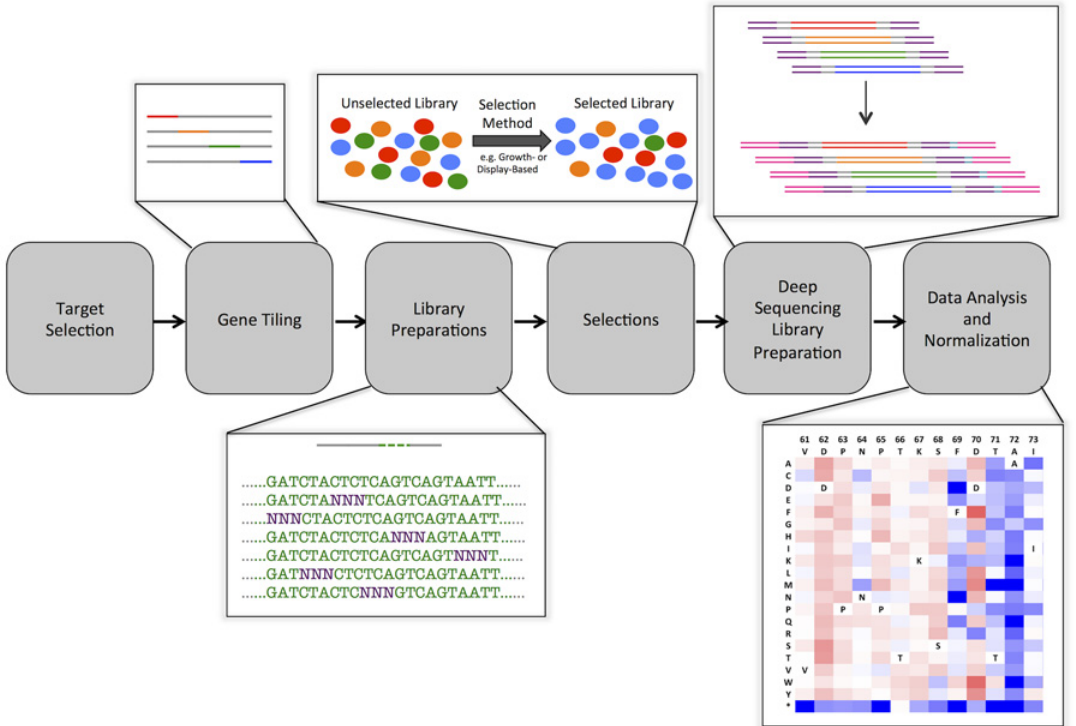
Fig 1. Overview of high-resolution sequence-function mapping process. Target Selection . Proteins of interest are selected for interrogation of sequence function relationships. A plasmid containing the gene-encoding sequence is generated. Gene tiling . Starting from this gene sequence, semi-overlapping tiles are generated to cover the entire gene. These tiles are either 150, 250 or 300 bp in length in order to be sequenced in paired-end mode on Illumina deep sequencing platforms. Library Preparation . The single-pot PFunkel method is used to generate a comprehensive single-site saturation mutagenesis library. Selections . Growth-based selections and FACS screens are used to resolve library populations; these selections should not completely converge on a few members of the population. It is important that the initial protein shows activity toward the selection method. Deep Sequencing and Library Preparation . After selection, cells are lysed and plasmid DNA is purified. The specific mutated tile region of the gene of interest is then amplified using overhang PCR, at which time Illumina sequencing primers and adaptors with selection-specific indexes are attached. Data analysis and normalization . Barcoded DNA is sequenced on a standard Illumina platform, analyzed, and normalized using custom scripts. The end result of this analysis is a comprehensive portrait of the effects of sequence on function for thousands of single point mutants in the gene of interest. These portraits can be used for various purposes such as improving protein binding affinity and specificity or improving enzymatic catalytic